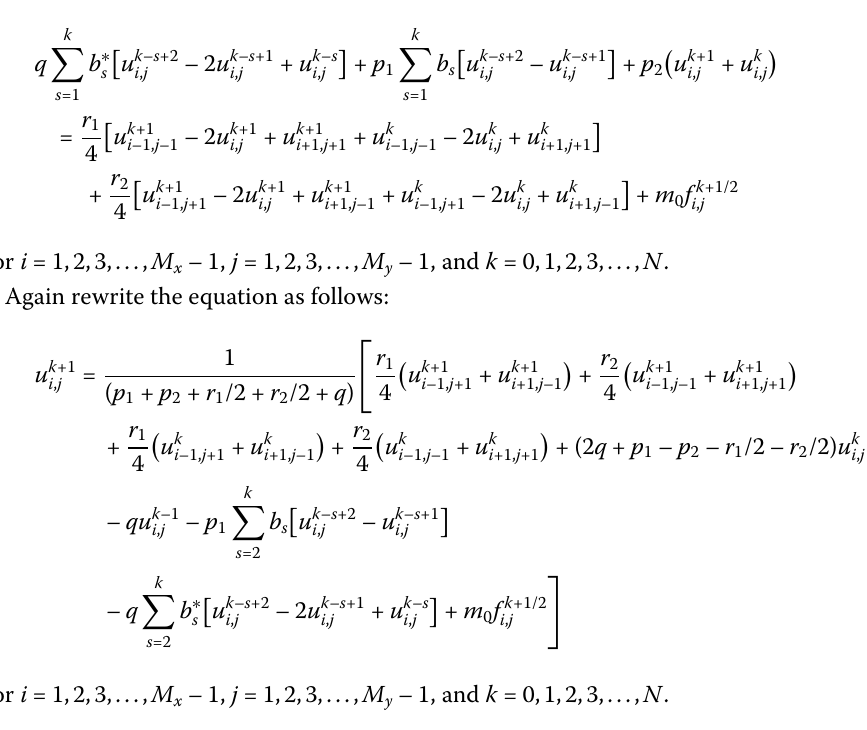
3 FSKG(C-N) scheme for 2D-HTFDE The expression for an FSkG(C-N) iterative scheme can be derived from the FSG(C-N) iter- ative scheme by rotating the grids clockwise an angle of 45 o with respect to the standard grids. Utilization of skewed Crank–Nicolson difference approximation and the Caputo fractional derivative of order 2 α and α from Eqs. (4) and (6) at the point ( x i , y j , t k +1/2 ) in Eq. (1) leads to the following